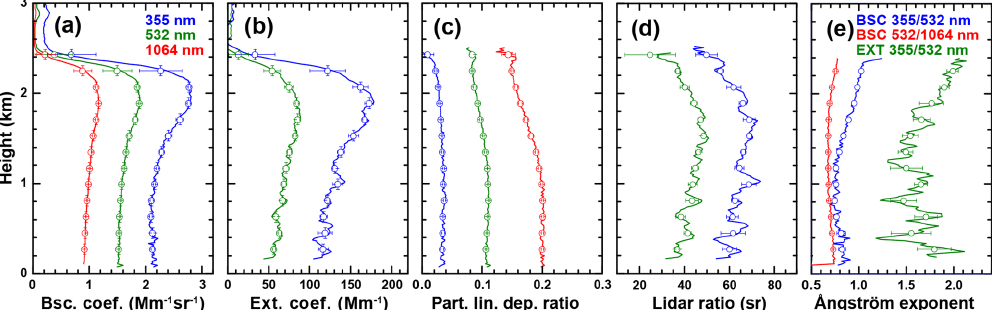
Figure 4. Same as Fig. 2 but for an HSRL-2 measurement performed during the second DISCOVER-AQ Texas flight on 25 September 2013 in the vicinity of Deer Park (29.670 ◦ N, 95.128 ◦ W). The coloured circles mark the data points we used to compile the inversion input data sets (Table 2). Details on the time of flight, dust mixing ratio, and aerosol types are given in Table